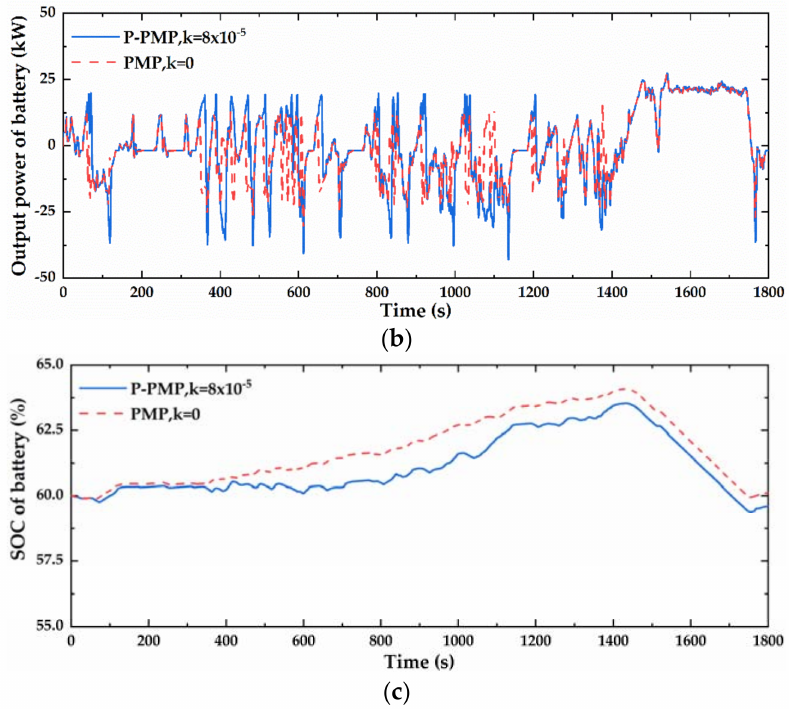
Figure 13. Comparison of the simulation results under P-PMP and PMP strategies. ( a ) Net output power of fuel cell; ( b ) Output power of battery; ( c ) SOC fluctuation of